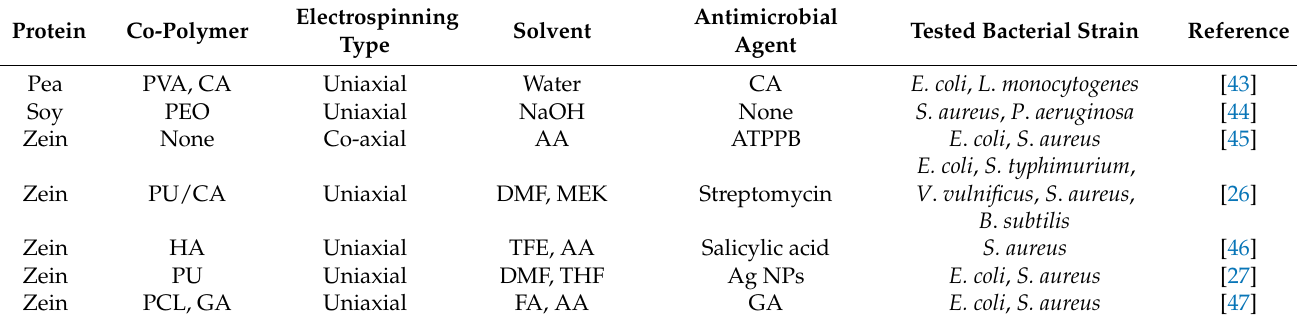
Table 1. Electrospun plant-based proteins with antimicrobial